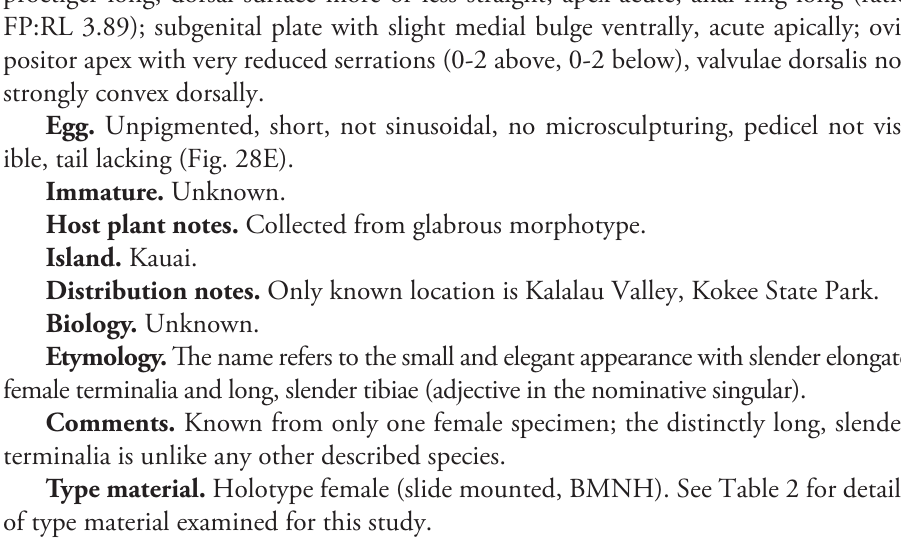
Adult colour. General body colour brown. Fore wing membrane clear. Adult structure. Fore wing apex bluntly acute; surface spinules sparsely distributed, few or none in cells r , cu , c+sc; short setae on margins and veins (Fig. 28A). Anten- 1 2 nae short (length 0.74; ratio AL:HW 1.28); genal processes short (ratio VL:GP 3.00) and rounded apically; medium short setae on vertex and short setae on thorax; distal proboscis segment medium-short (length 0.12); hind tibia slender and longer than head width (ratio HW:HT 0.92) (Fig. 28B–D, F). Female terminalia (Fig. 28G–H): proctiger long, dorsal surface more or less straight, apex acute, anal ring long (ratio FP:RL 3.89); subgenital plate with slight medial bulge ventrally, acute apically; ovi- positor apex with very reduced serrations (0-2 above, 0-2 below), valvulae dorsalis not strongly convex